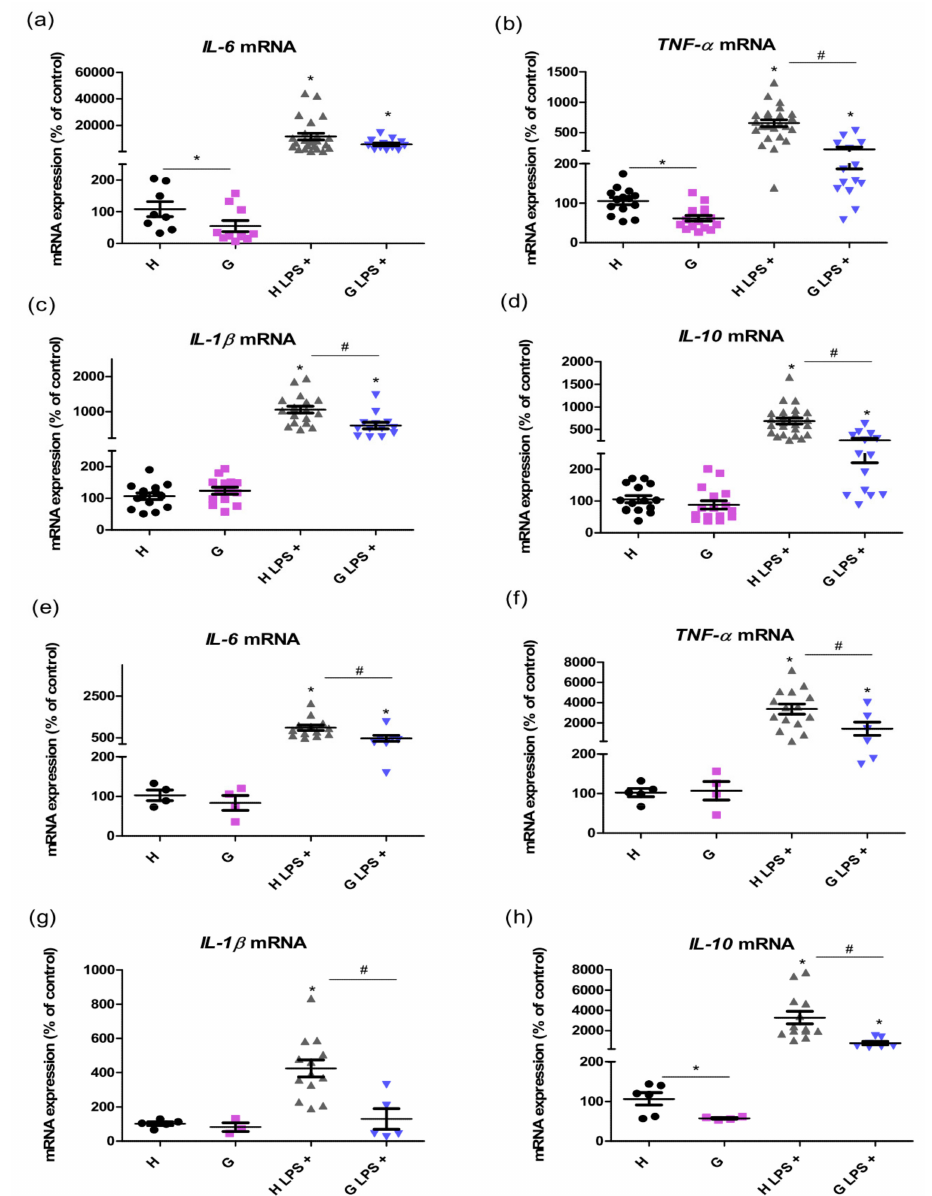
Figure 2. The e ff ects of LPS-induced inflammation on mRNA cytokine expression in the liver and WBC of hyperbilirubinemic Gunn rats. mRNA expressions of pro- and anti-inflammatory cytokines IL-6 , TNF- α , IL-1 β , and IL-10 were measured in the liver tissue ( a – d ) and white blood cells ( e – h ) 12 h after saline or LPS administration (6 mg / kg i.p.) in normobilirubinemic heterozygous controls (H or H LPS + ) and hyperbilirubinemic Gunn rats (G or G LPS + ), respectively. * p < 0.05 vs. corresponding control, # p < 0.05 vs. LPS-treated group. n = 5 animals per group